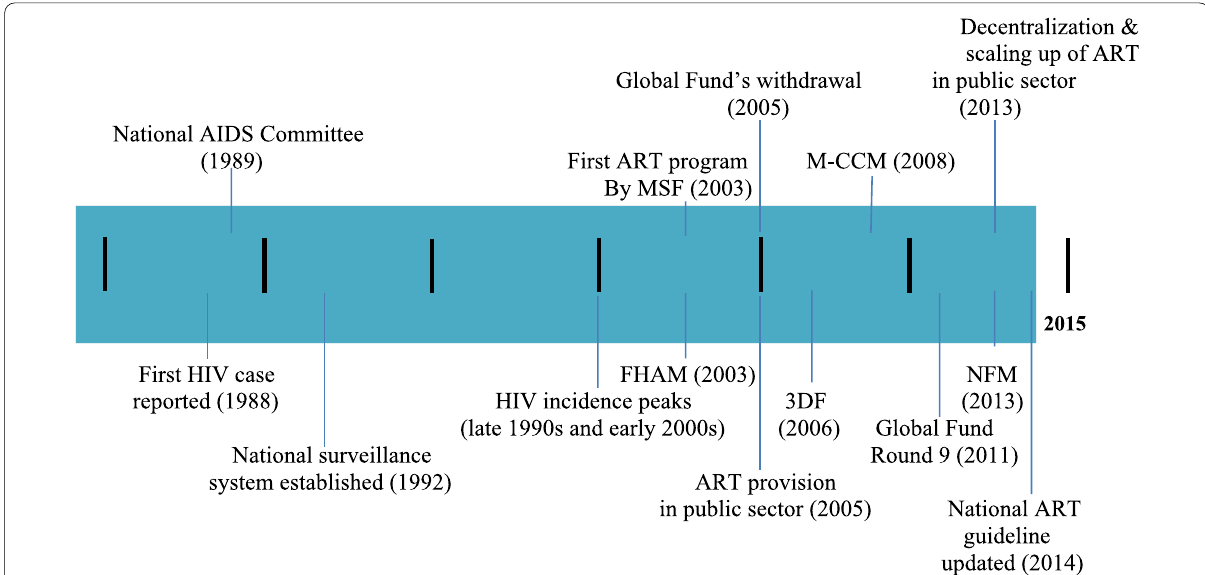
Fig. 1 Historical timeline of the national response to HIV/AIDS in Myanmar (1985–2015). Note : 3DF, Three Diseases Fund; ART, Antiretroviral therapy; FHAM, Fund for HIV/AIDS in Myanmar; M-CCM, Myanmar country coordinating mechanism; MSF, Médecins Sans Frontières; NFM, New funding